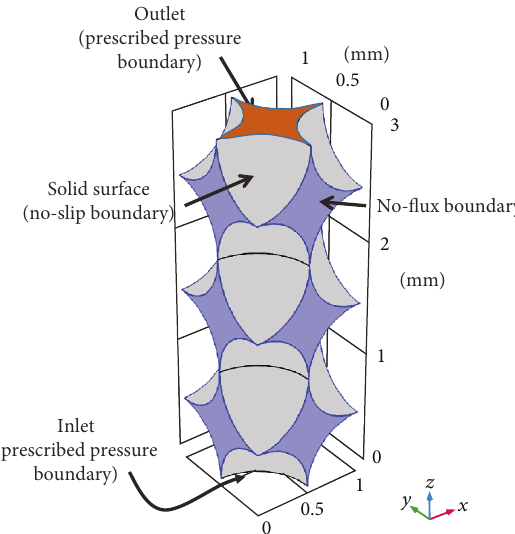
Figure 7: A void space formed among equal-sized solid spheres. The top face (red) is the outlet, and the bottom face (hidden) is the inlet; all the lateral planes (blue) are no- fl ow boundaries; the spherical faces (gray) are interfaces between the void and solid and are treated as a no-slip boundary in dynamic simulation.